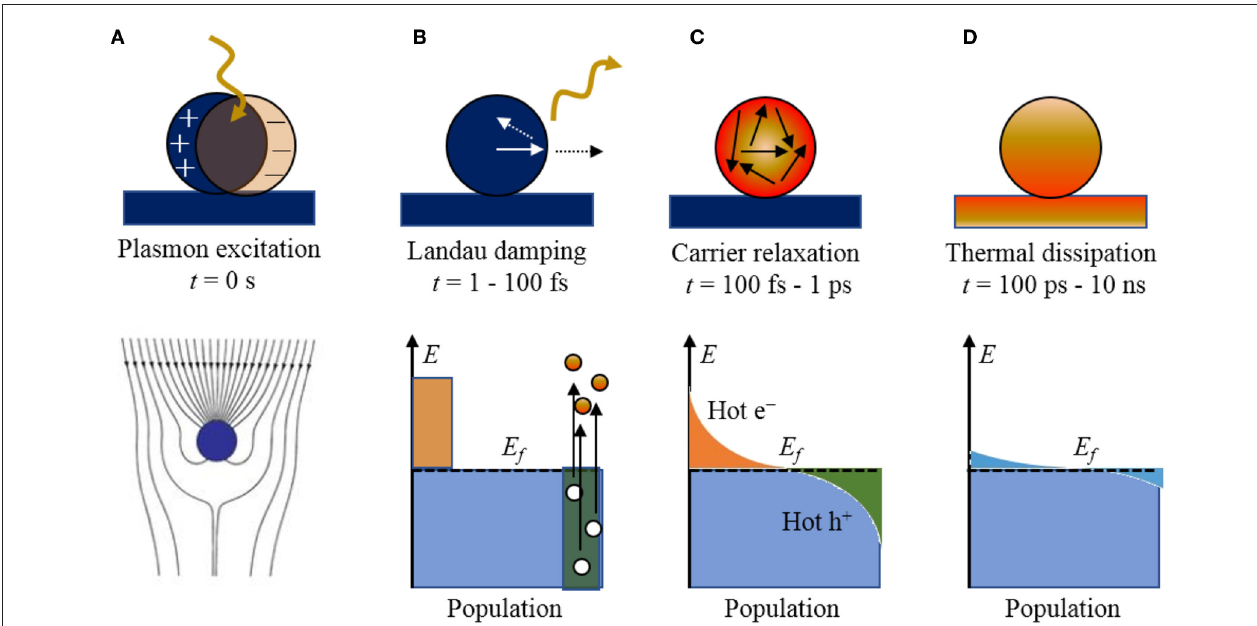
FIGURE 1 | The stepwise processes of photoexcitation and electronic relaxation for a metallic nanoparticle with the characteristic timescales and population of electronic states: (A) excitation of a localized surface plasmon, (B) Landau damping and the creation of electron-hole pairs, (C) carrier relaxation and thermalized “hot” distribution of carriers, and (D) thermal dissipation to the surroundings. The Fermi level is labeled by E f . Adapted with permission from Brongersma et al. (2015). Copyright 2015 Spring